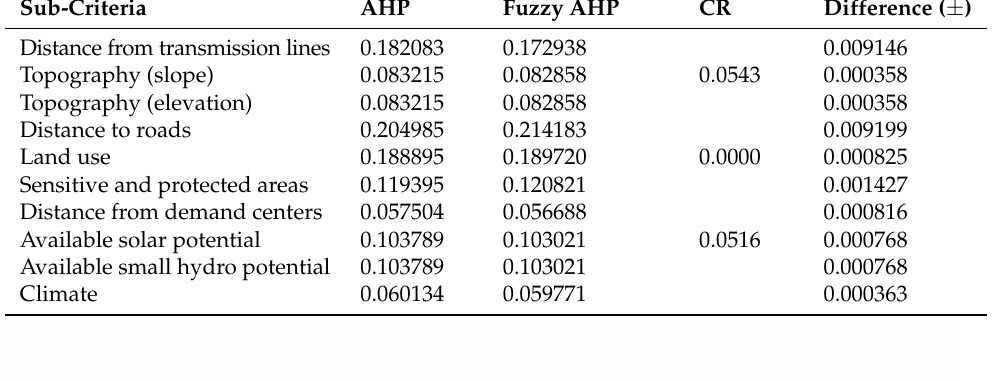
Table 4. Sub-criteria weights on using AHP and fuzzy AHP models.